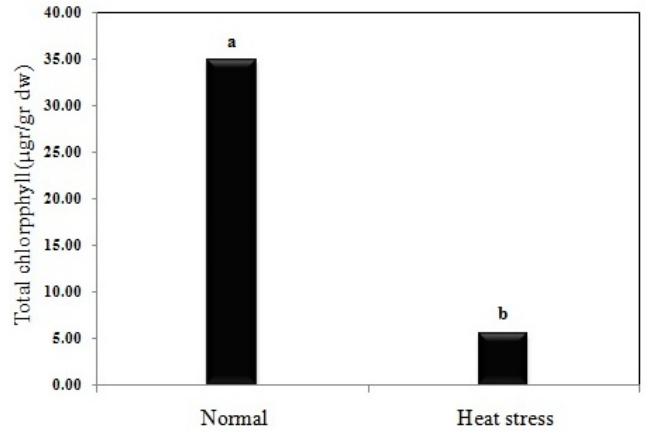
Figure 1. Comparison of the simple effect of normal and heat stress conditions on the total chlorophyll content in chamomile dried leaves. content in chamomile dried